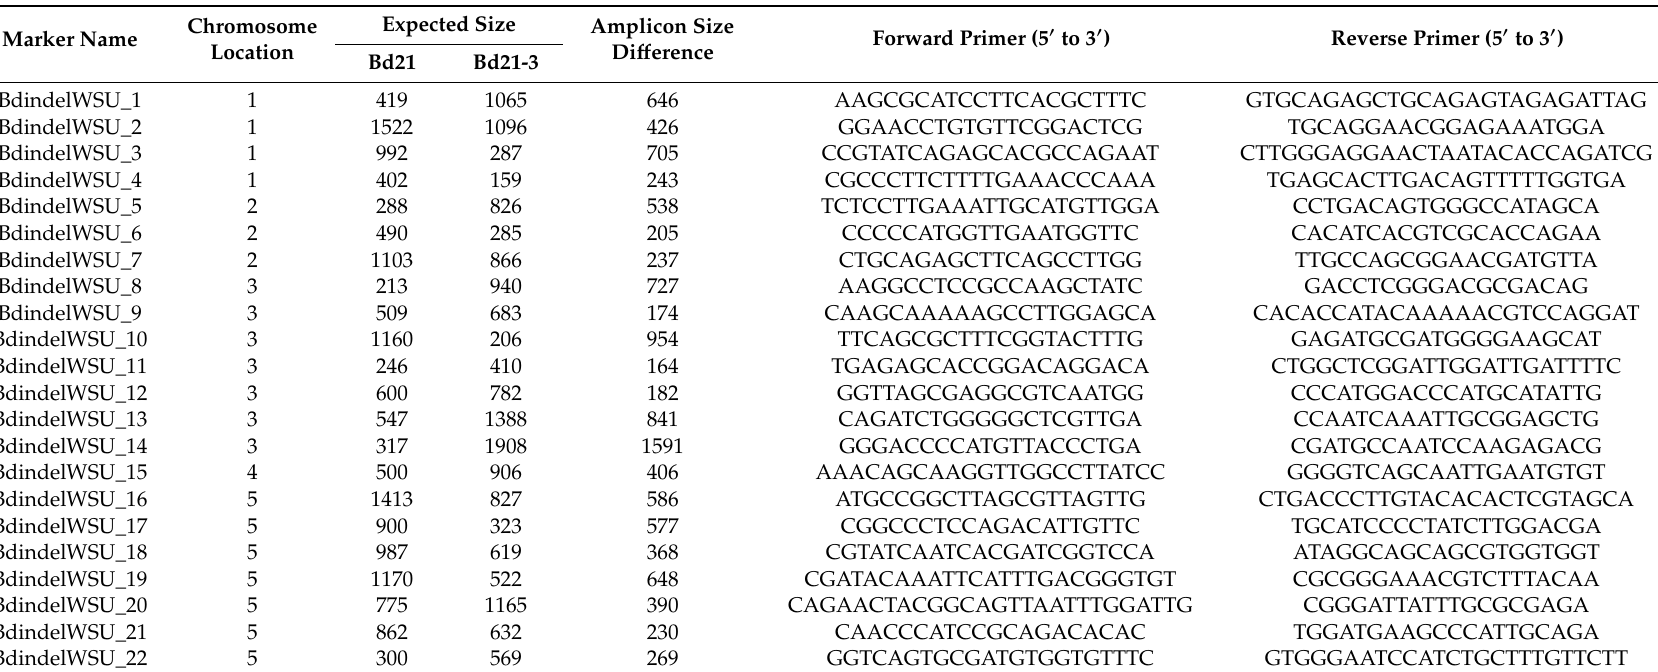
Table 1. Length polymorphism markers predicted for Brachypodium distachyon accessions Bd21 and Bd21-3. The sequences were obtained from the Phytozome database (Version 12.1.6), primers were designed with the Primer3Plus software and amplicon sizes were predicted with the PCR tool in the Serial Cloner software (Version